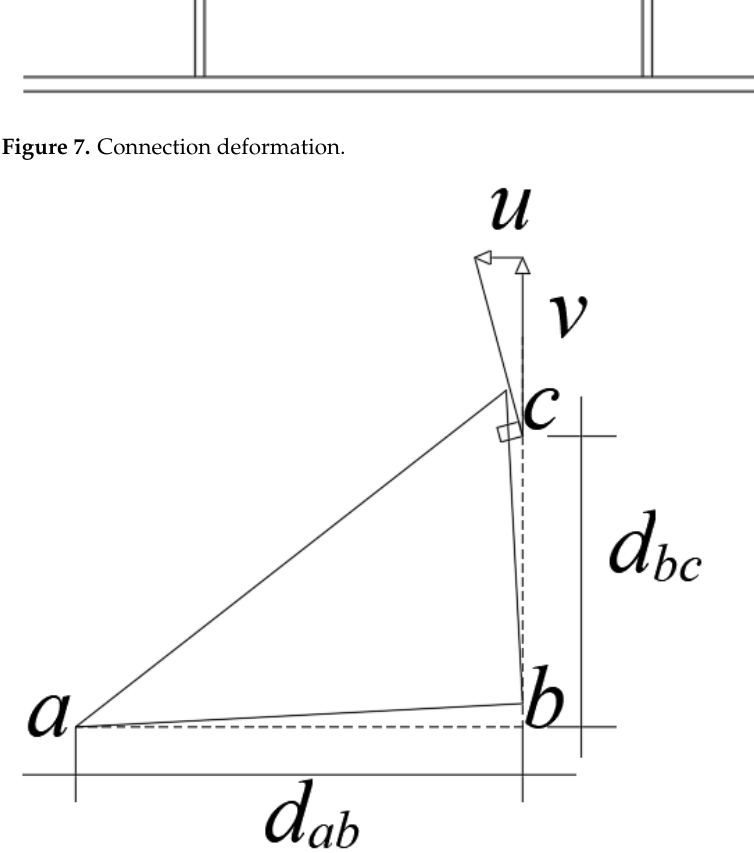
Figure 8. Rotational deformation.